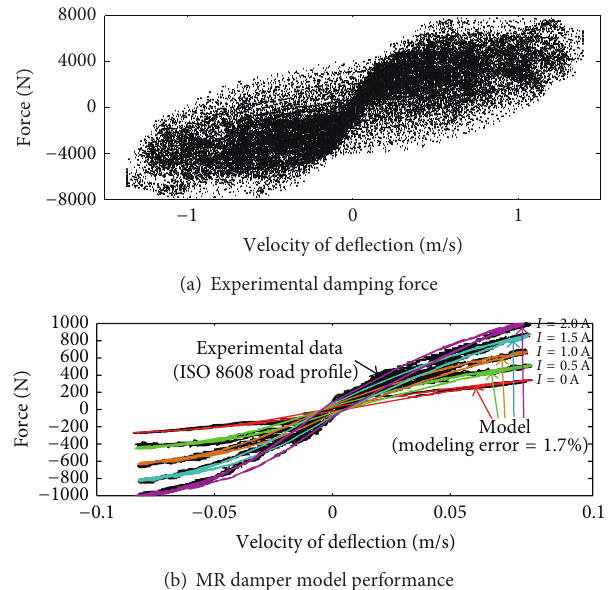
Figure 6: (a) Experimental data of the commercial MR damper when the damper rod is excited by a chirp signal from 0.5 to 15Hz at different stepped values of electric current from 0 to 6 A. (b) MR damper modeling for different 𝐼 values, when 𝛼 =